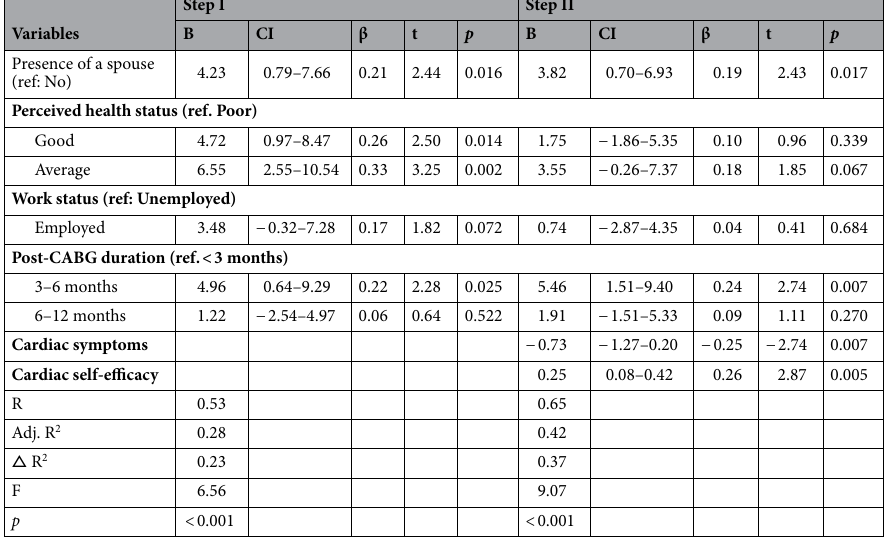
Table 5. Hierarchical regression of physical health-related Quality of Life (N = 110). CABG coronary artery bypass graft, CI confidence interval.